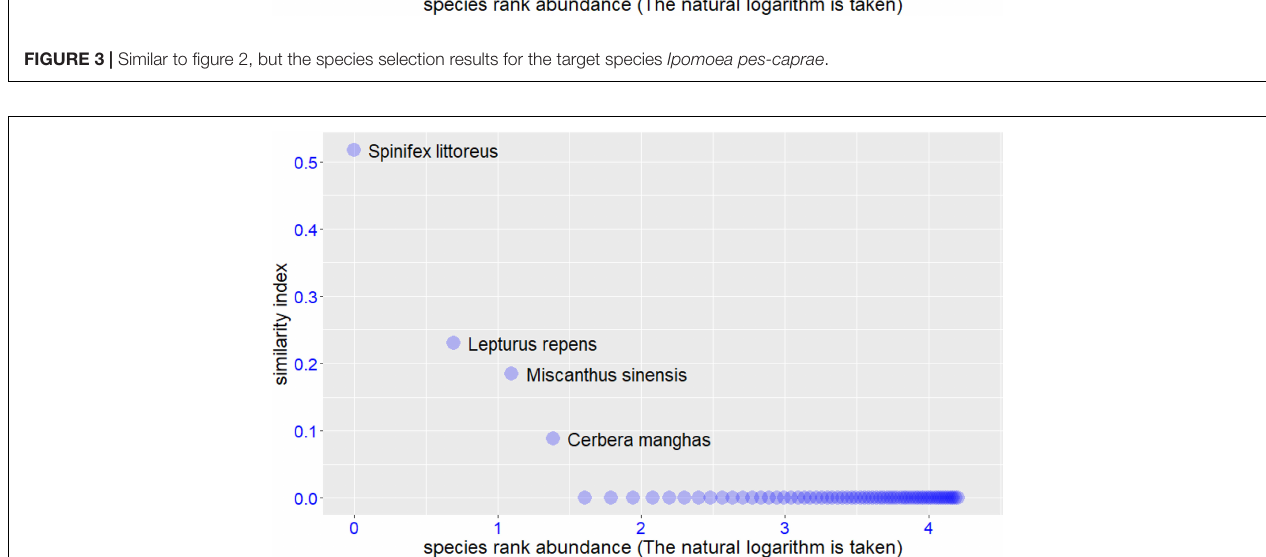
Frontiers in Ecology and Evolution |